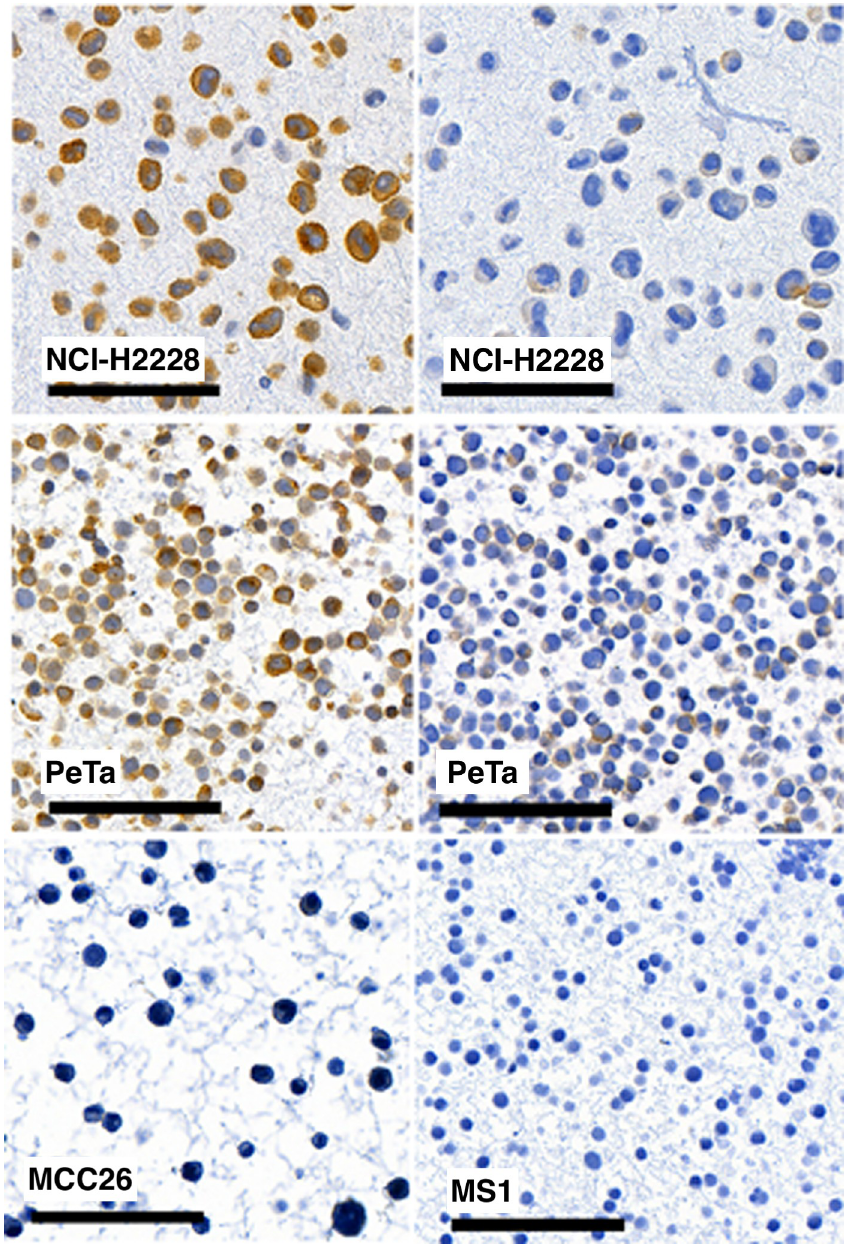
Fig 3. Analysis of the IHC expression of ALK (left column) and p-ALK (right column) in lung cancer cell line NCI-H2228 and in MCC cell lines PeTa and MCC26/MS1. Size bar 100 μ m.”.